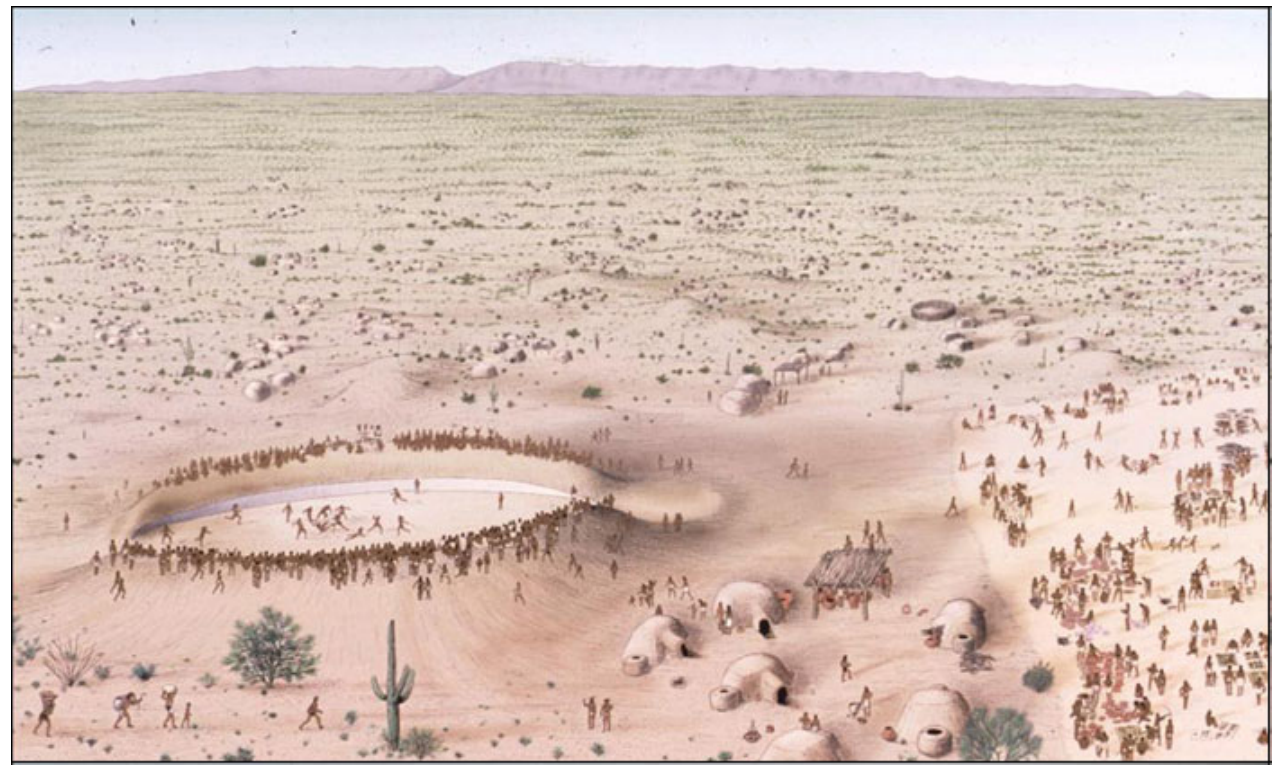
Fig. 12 . Hohokam ball courts were ceremonial, social, and market centers for a vast regional population. Copyright by Western National Parks Association. Used by